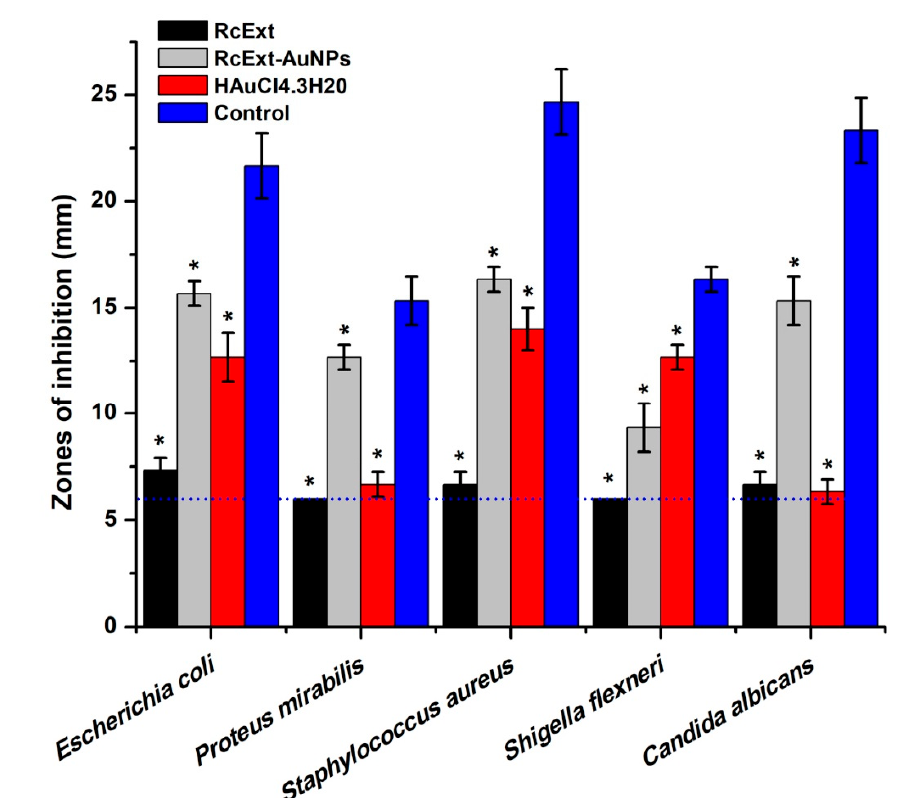
Figure 10. Antimicrobial potentials of (i) Ricinus communis leaf extract (RcExt); (ii) the extract with gold nanoparticles (RcExt-AuNPs); (iii) HAuCl 4 · 3H 2 O (1 mM); and (iv) the control (Penicillin–Streptomycin (20 units) against selected microbial strains. Values ≤ 6.00 mm (the dotted line) imply no antimicrobial activity as it corresponds to the diameter of a well. All data are represented as mean ± standard deviation (indicated as error bars) from three determinations. Means with asterisk (*) signs in each microbial group indicate a significant ( p ≤ 0.05) difference among the treatments and control.